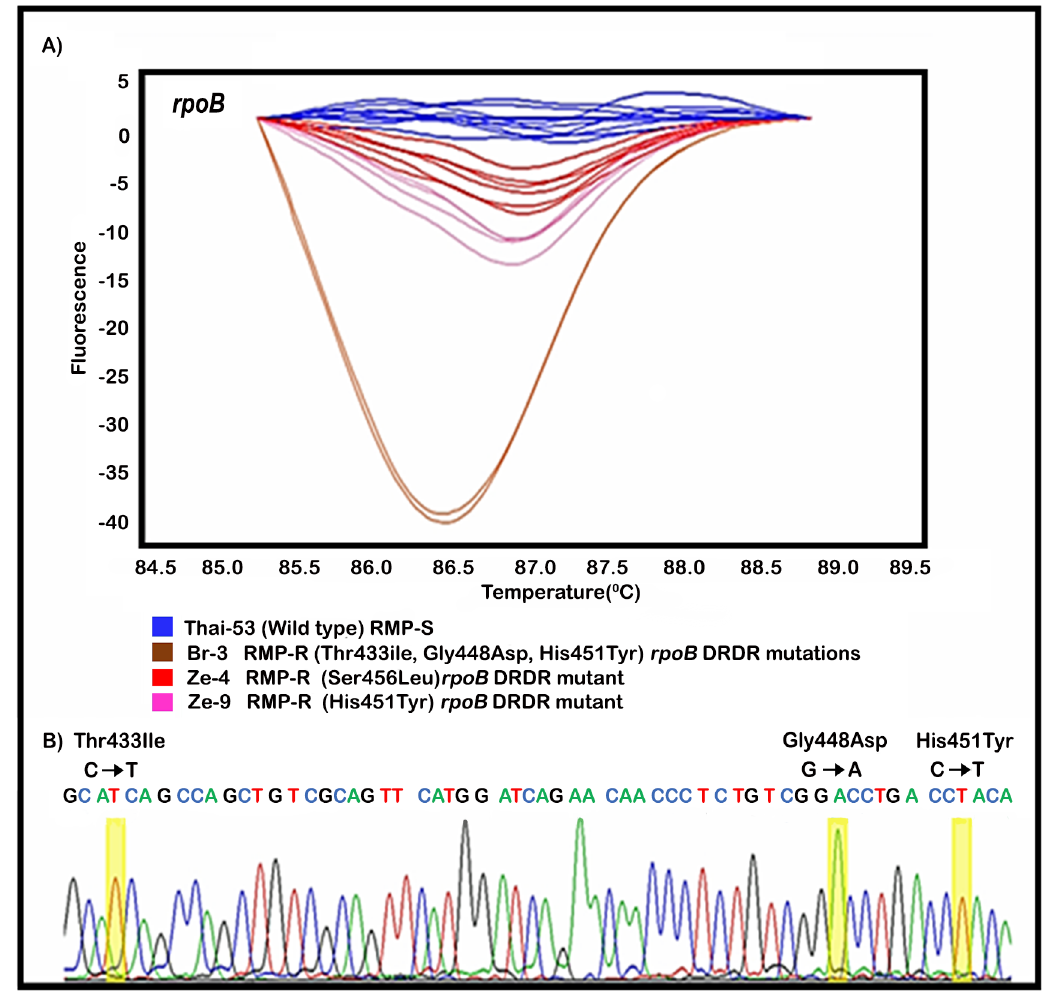
Fig 1. Comparison of M . leprae qPCR-HRM DST and PCR/DNA sequencing DST results of RMP-resistant M . leprae Br-3. A) Differenceplots graphicdisplay of the post-qPCR HRM analysisof the rpoB drug resistancedetermining region(DRDR) of M . leprae Br-3. The DNA melting curves obtained in the analysisof mutant strains, deviate from the wild type profile (Thai-53 strain, shownin bluecolor). B) DNA chromatogram result for the DNA sequenceof rpoB DRDR of M . leprae Br-3 sample, showingthree independent mutations associatedwith RMP